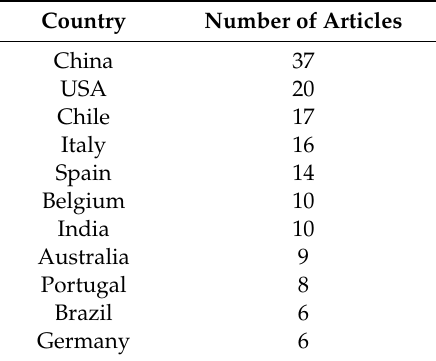
Table 3. Most productive